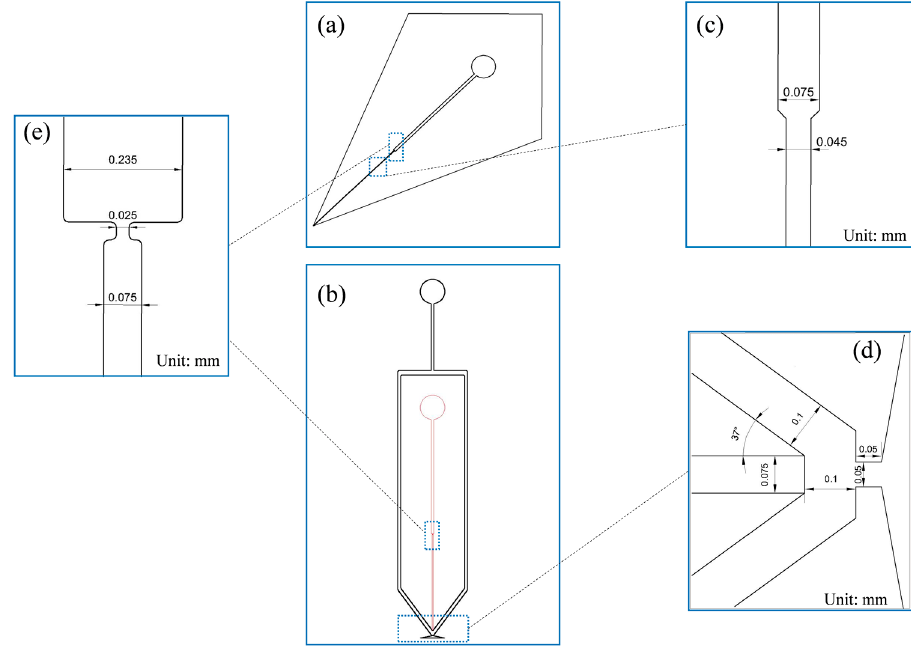
Figure 1. Photo mask, bottleneck structure size and nozzle size of integrated-corner electrospray ionization (ESI) emitter and flow focusing (FF) ESI emitter: ( a ) Photo mask of the integrated-corner ESI emitter; ( b ) Photo mask of the FF ESI emitter; ( c ) Nozzle width of integrated-corner ESI emitter; ( d ) Nozzle width of FF ESI emitter; ( e ) Bottleneck structure size.